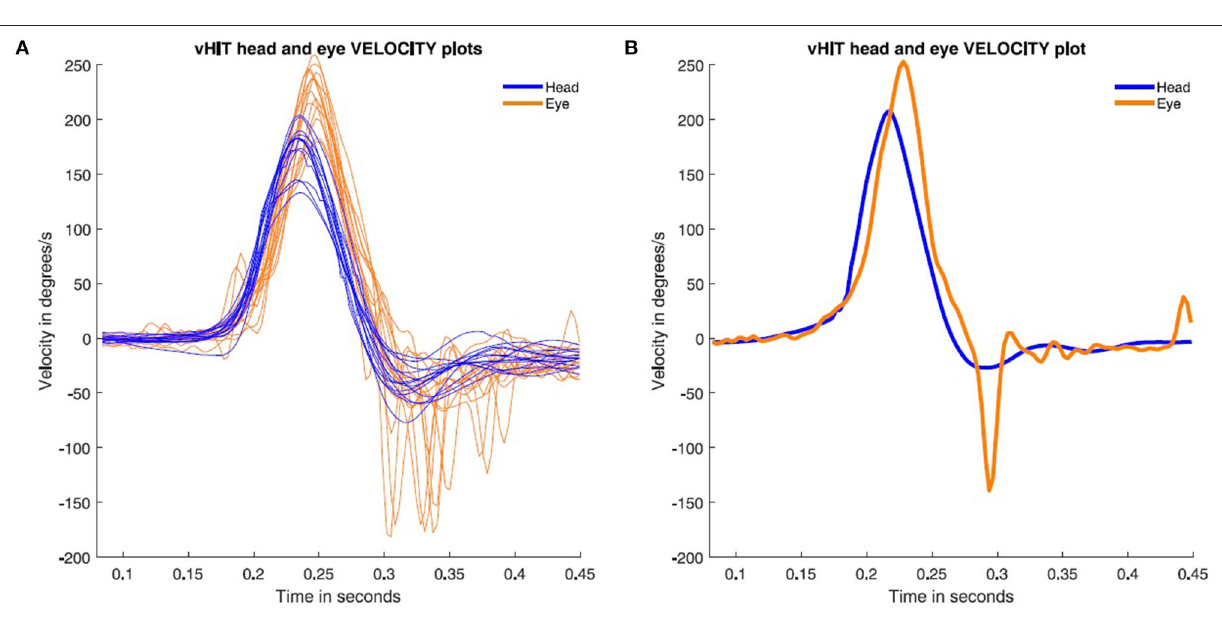
FIGURE 2 | Rightward video head impulse test responses performed during the patient’s most recent test (2021). The eye velocity (orange) is enhanced compared to head velocity (blue). This will result in the eye being off target and in order to correct that gaze position error ( Figure 4 ) the eye makes a compensatory